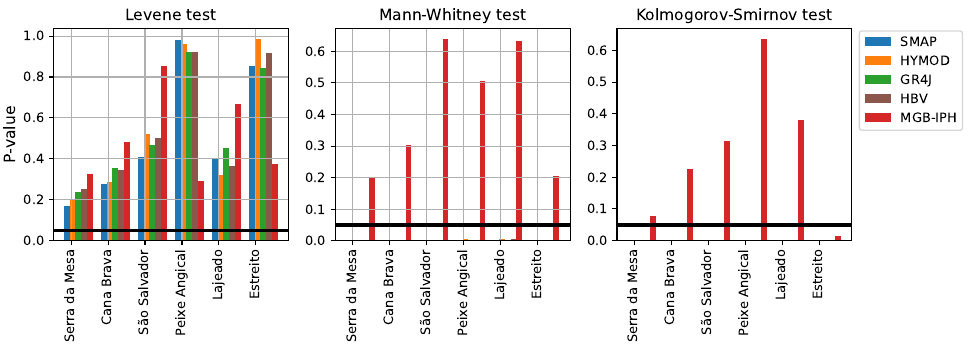
Figure 12. Statistical tests of each hydrological model in the validation stage. The horizontal line indicates the significance level α =